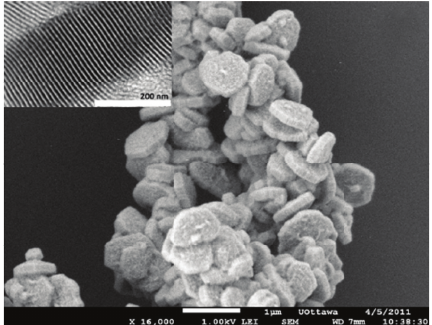
Figure 5: HRSEM image of the SBA-15 mesoporous silica resulting from the use of decane. Reprinted with permission from [51]. Copyright (2006) American Chemical Society.